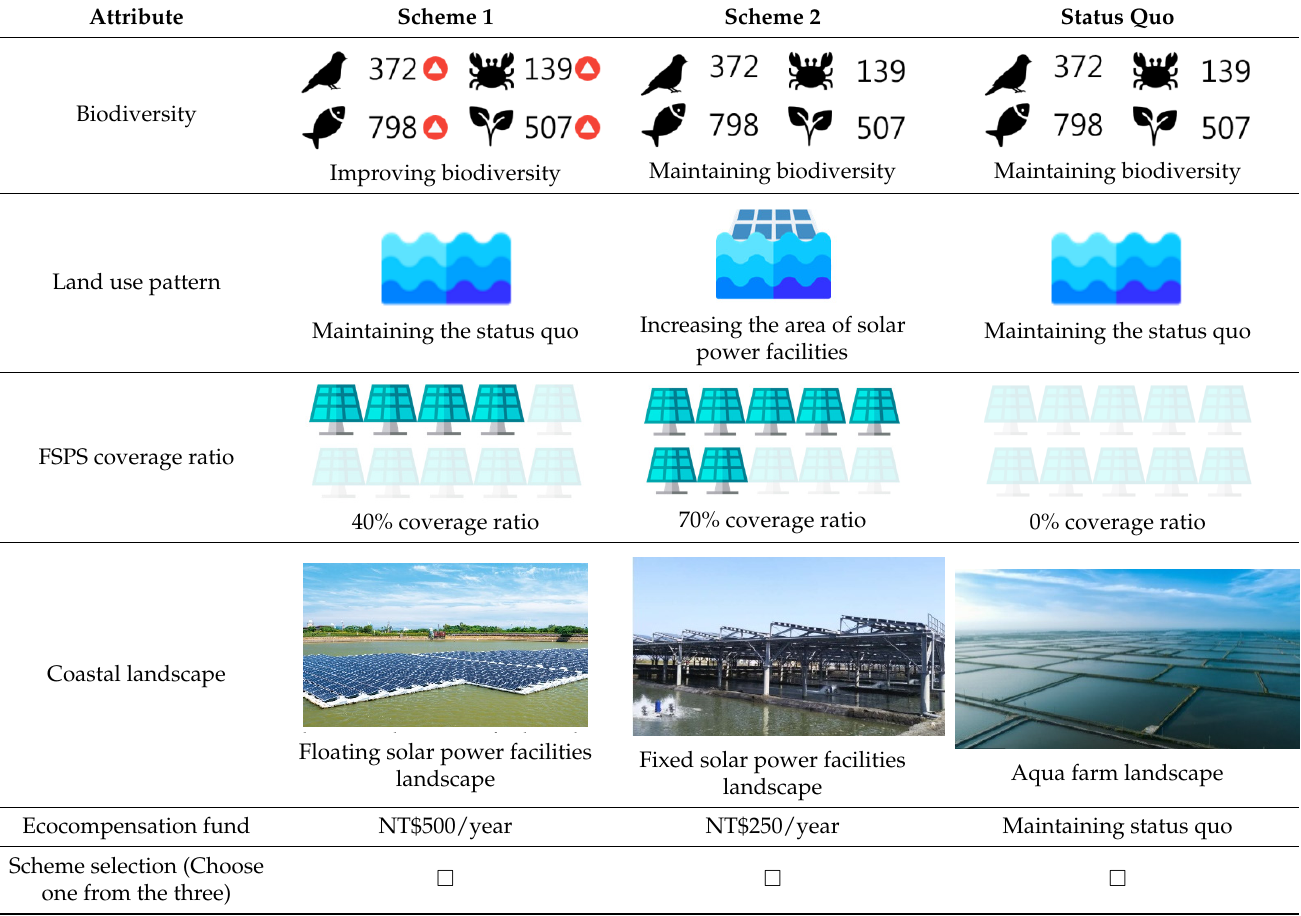
Table 1. Questionnaire design example.